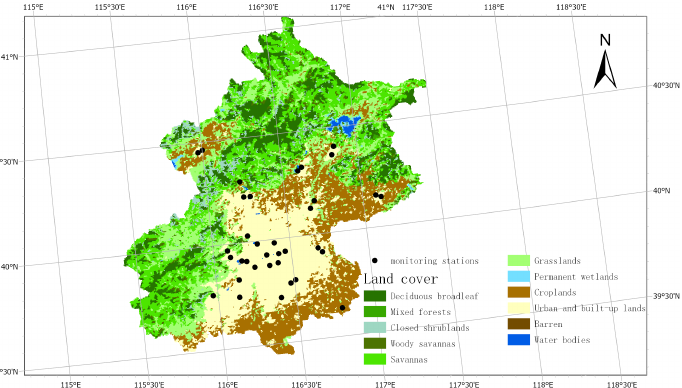
Figure 1. Study area and spatial distribution of ground-level monitoring